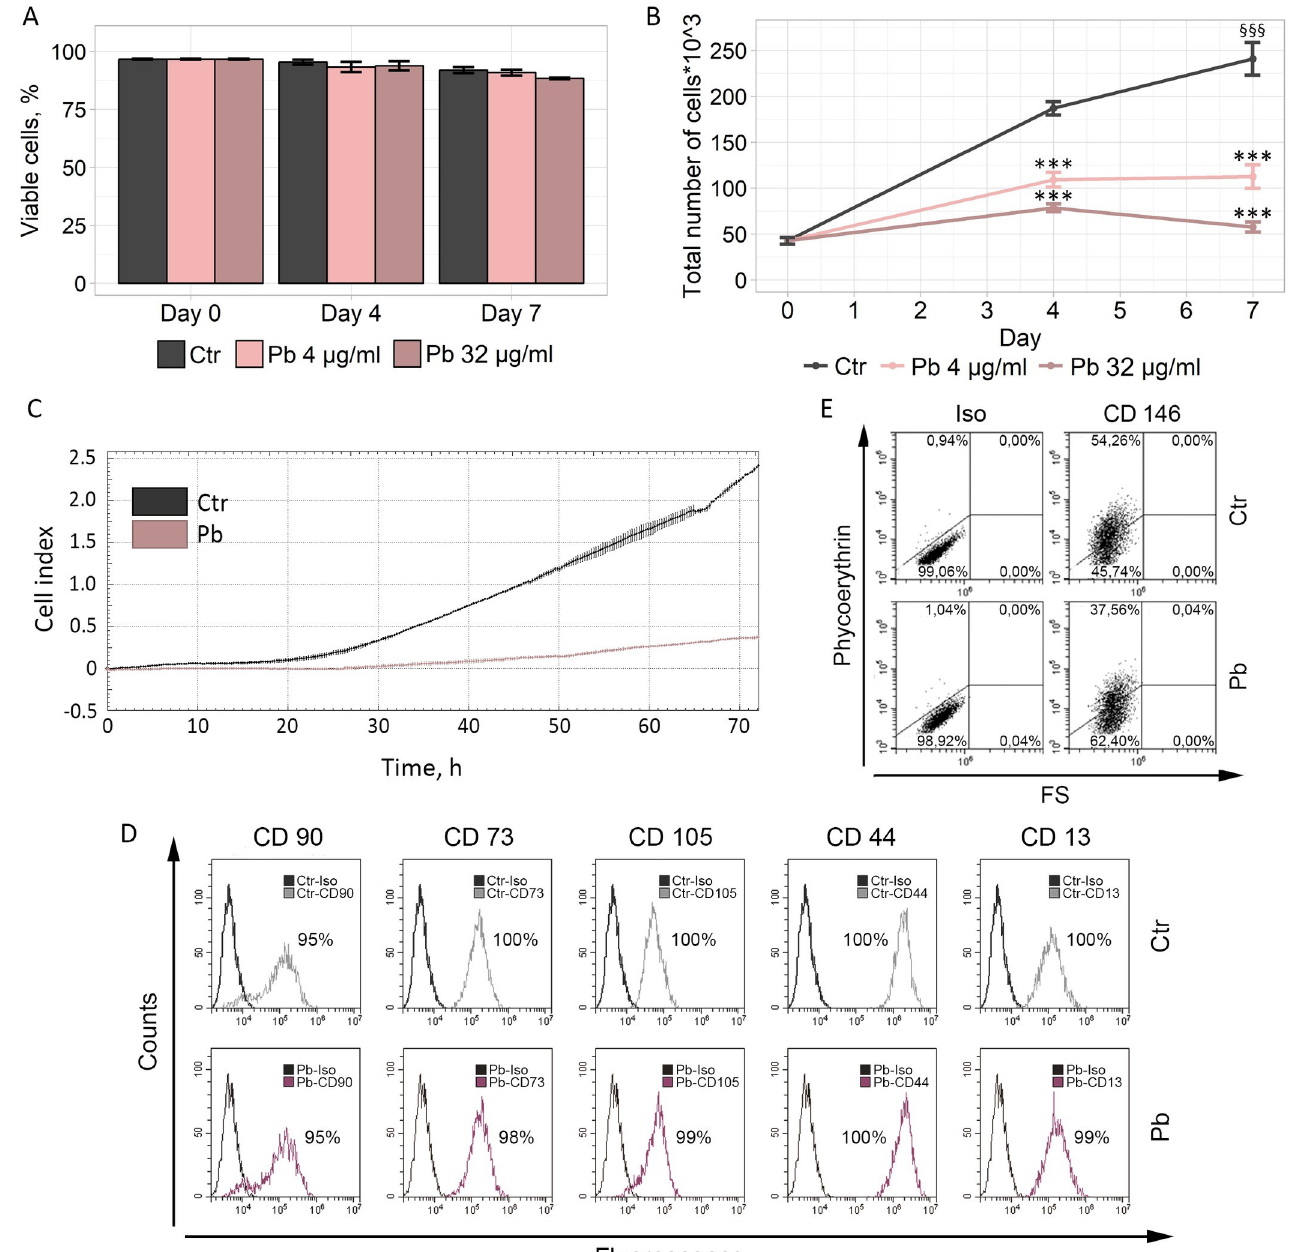
Fig 1. Pb has no effect on hMESCs viability and immunophenotype but has a negative impact on proliferation, migration and CD 146 expression. Except A and B hereinafter “Pb” means the use of Pb in concentration 32 μ g/ml. “Ctr”–control cells. (A) Percentage of viable cells evaluated by flow cytometry. (B) Growth curves of Ctr and Pb-treated hMESCs. Cell number was determined by flow cytometry at indicated time points. (C) Migration analysis performed with the use of XCELLigence system. Lines represent cell index M ± SD values at multiple time points. (D, E) Expression of common MSCs surface markers in Ctr